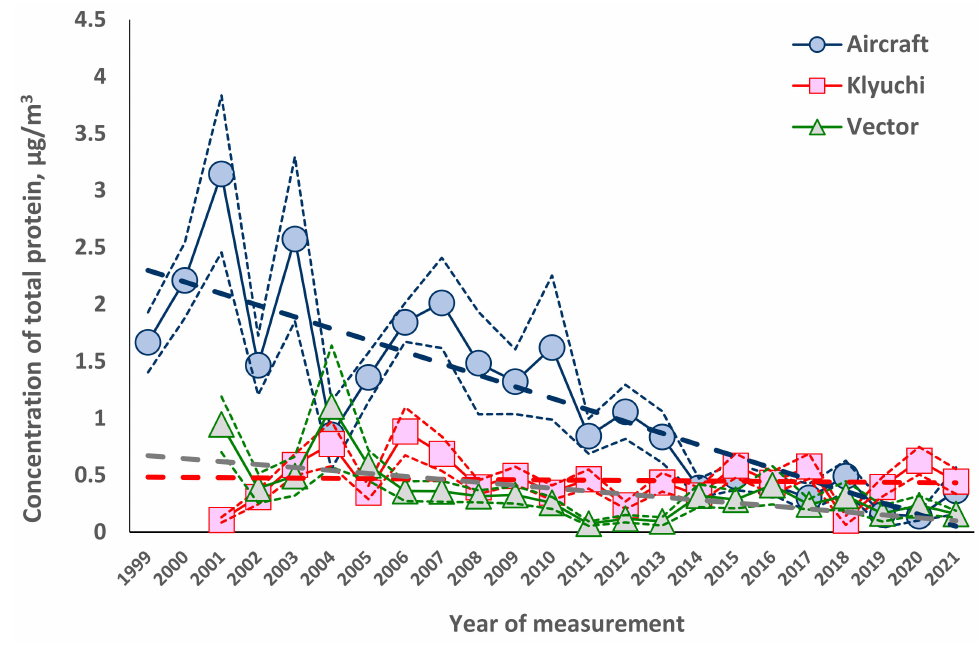
Figure 1. Trends in the average annual concentration of total protein, measured at three locations near Novosibirsk. The figure shows the equations of the trend lines and the values of the reliability of the constructed approximation.